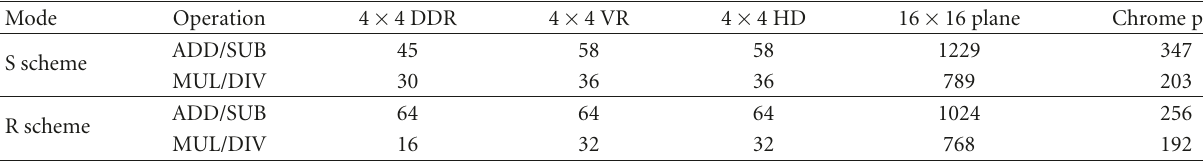
Table 2: Computational complexity analysis of R scheme.